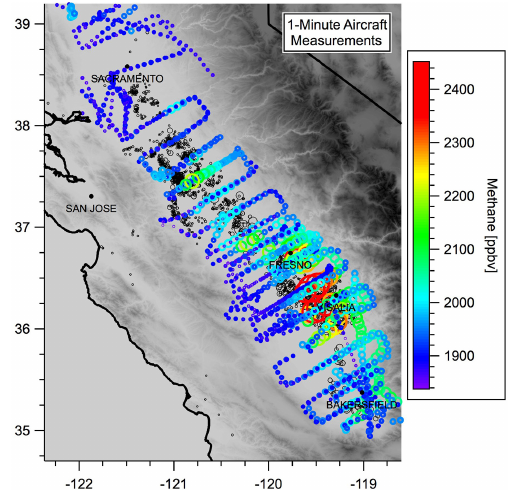
Figure 13. Aircraft canister measurements of ethanol in Califor- nia’s Central Valley shown as individual circles, sized and colored by ethanol concentration. Data were taken at varying altitudes above and below the boundary layer with a general filter for below 1000m. Vertical gradients are responsible for some variability, but aircraft data support conclusions of other analyses showing large ethanol sources in the Central Valley: dairy operations in the San Joaquin Valley and rice cultivation in the Sacramento Valley. Note: meteo- rological conditions and local dilution varies between canister mea- surements. Also, alcohol measurements made using the canisters were prone to significant losses, so their use is only relative.